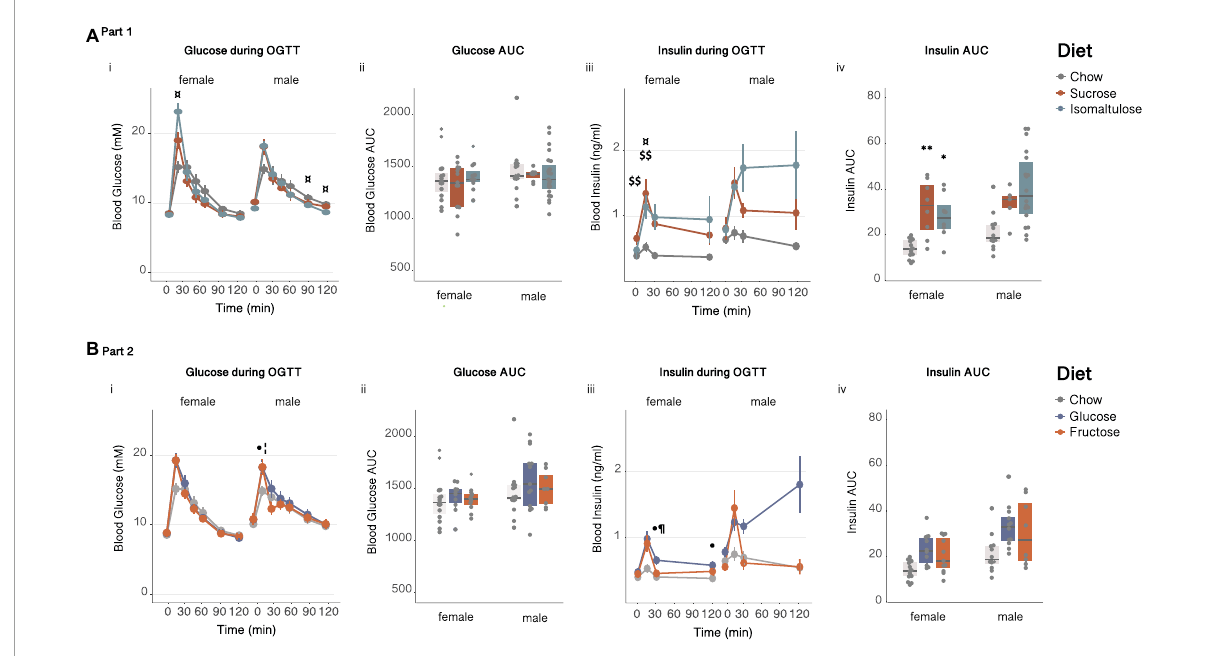
FIGURE7 Glucose homeostasis in pups (A) in Part 1 and (B) in Part 2: Female and male pup response to an oral glucose tolerance test at 12 weeks of age (i) glucose over time, (ii) glucose AUC, (iii) insulin over time and, (iv) insulin AUC. n = 7–21 per diet per sex. Line graphs depict data as mean ± SEM. * p < 0.05 vs. chow; ** p < 0.01 vs. chow; $$ p < 0.01 sucrose vs. chow; p < 0.05 isomaltulose vs. chow; · p < 0.05 glucose vs. chow; p < 0.05 fructose vs. chow; p < 0.05 glucose vs.